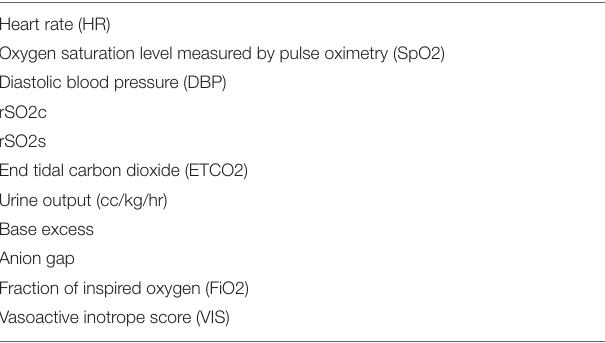
TABLE 1 | Clinical features most important to the XG-boost algorithm.